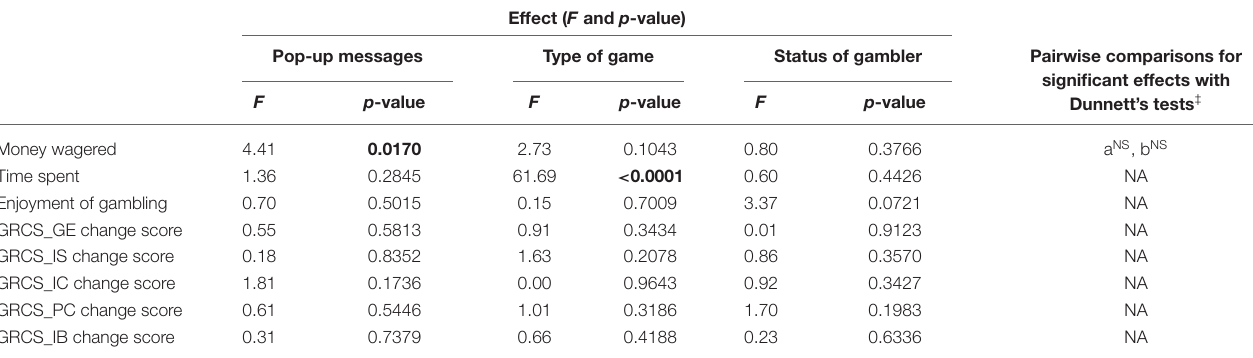
TABLE 2 | ANOVA results adjusted for the status of gamblers and the type of gambling comparing the 2 experimental conditions with the control condition for differences between the pre-test (T0) and 1st post-test (T1). Effect ( F and p -value) Pop-up messages Type of